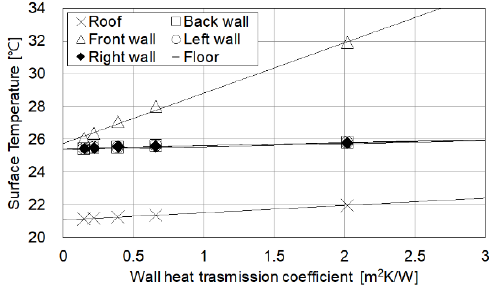
Figure 9. Heat transmission coefficient and surface temperature for each wall (Case U_2.02, sol-air temp = 60 ℃ ).